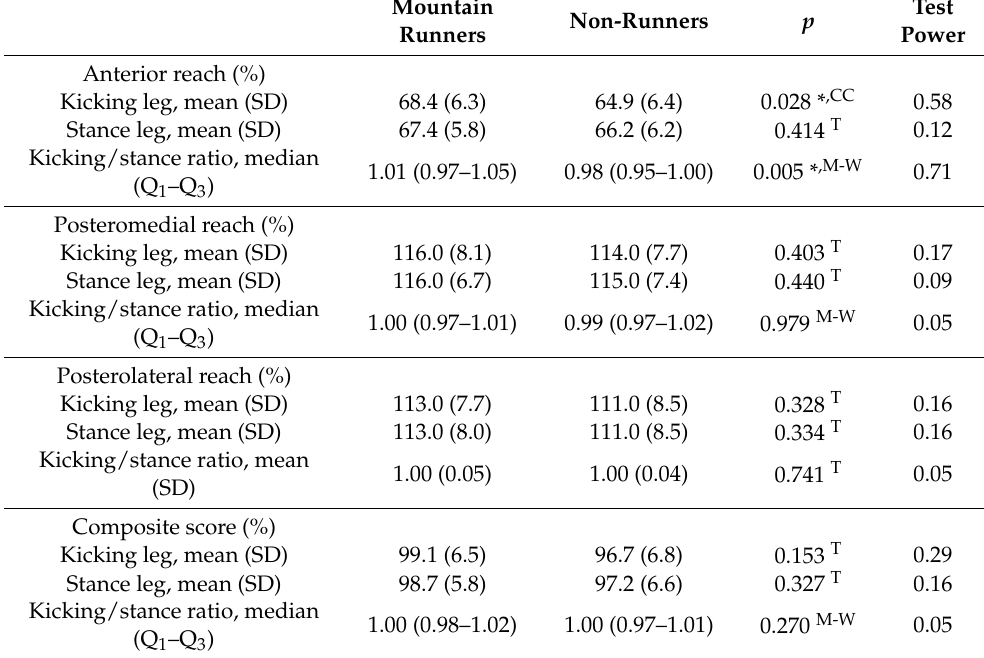
Table 5. Lower quarter Y-balance test